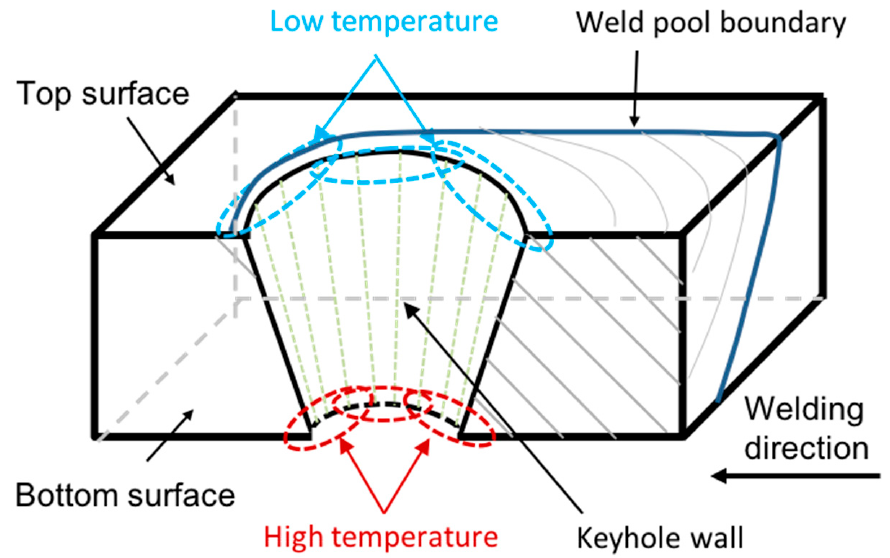
Figure 3. Schematic illustration of longitudinal section of the keyhole and the weld pool in keyhole plasma arc welding (KPAW).